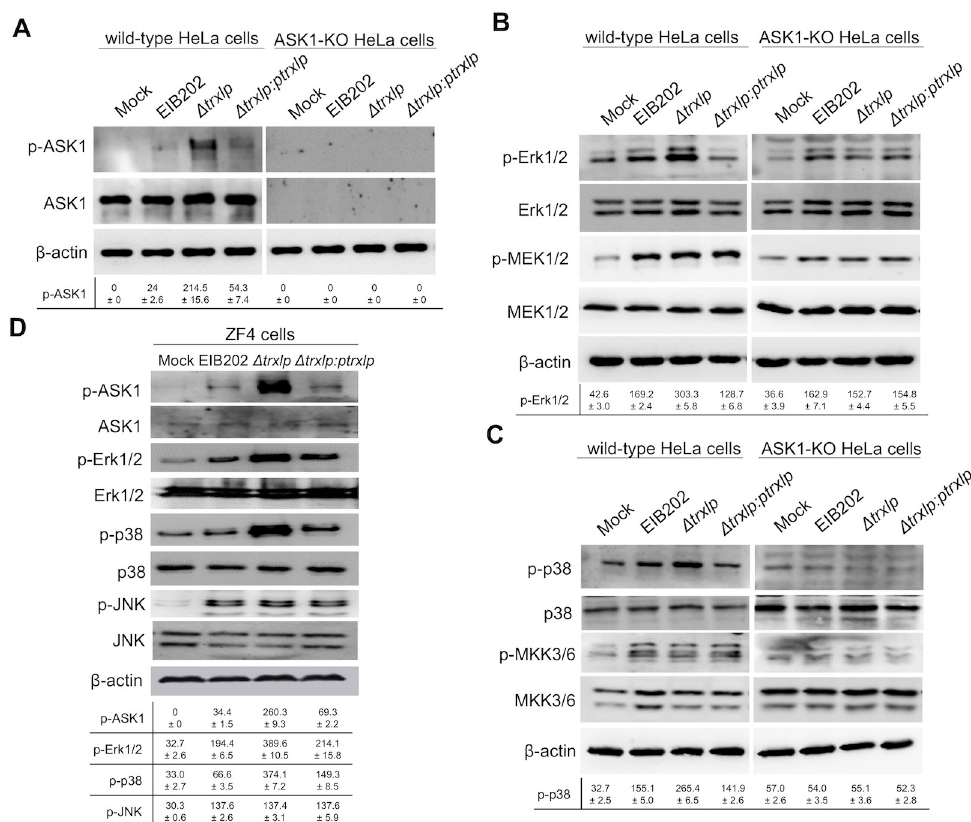
Fig 4. Trxlp suppresses the phosphorylation of Erk1/2 and p38 dependent on ASK1 during E . piscicida infection. ( A-C) Immunoblotting assays of ASK1, MAP2Ks and MAPKs activation during E . piscicida infection in HeLa cells. Wild- type HeLa cells and ASK1-KO HeLa cells were infected with EIB202, Δ trxlp , or trxlp- complemented E . piscicida at a MOI of 100 for 2 h. Cell lysates were collected and probed for anti-phospho-ASK1 and anti-ASK1 antibodies (A), or probed for anti-phospho-Erk1/2 and anti-Erk1/2, and anti-phospho-MEK1/2 and MEK1/2 antibodies (B), or probed for anti- phospho-p38 α and anti-p38 α , and anti-phospho-MKK3/6 and MKK3/6 antibodies (C). (D) Immunoblotting assays of ASK1 and MAPKs activation during E . piscicida infection in Zebrafish fibroblasts (ZF4). ZF4 cells were infected with EIB202, Δ trxlp , or trxlp- complemented E . piscicida for 2 h at a MOI of 10. Cell lysates were probed with anti-phospho- ASK1 and anti-ASK1, anti-phospho-Erk1/2 and anti-Erk1/2, anti-phospho-p38 and anti-p38, anti-phospho-JNK and anti- JNK antibodies. (A-D) β -Actin is shown as a loading control. The signal intensities were quantitatively analyzed using Quantity one software. Data (Means ± SD) are representative of at least 3